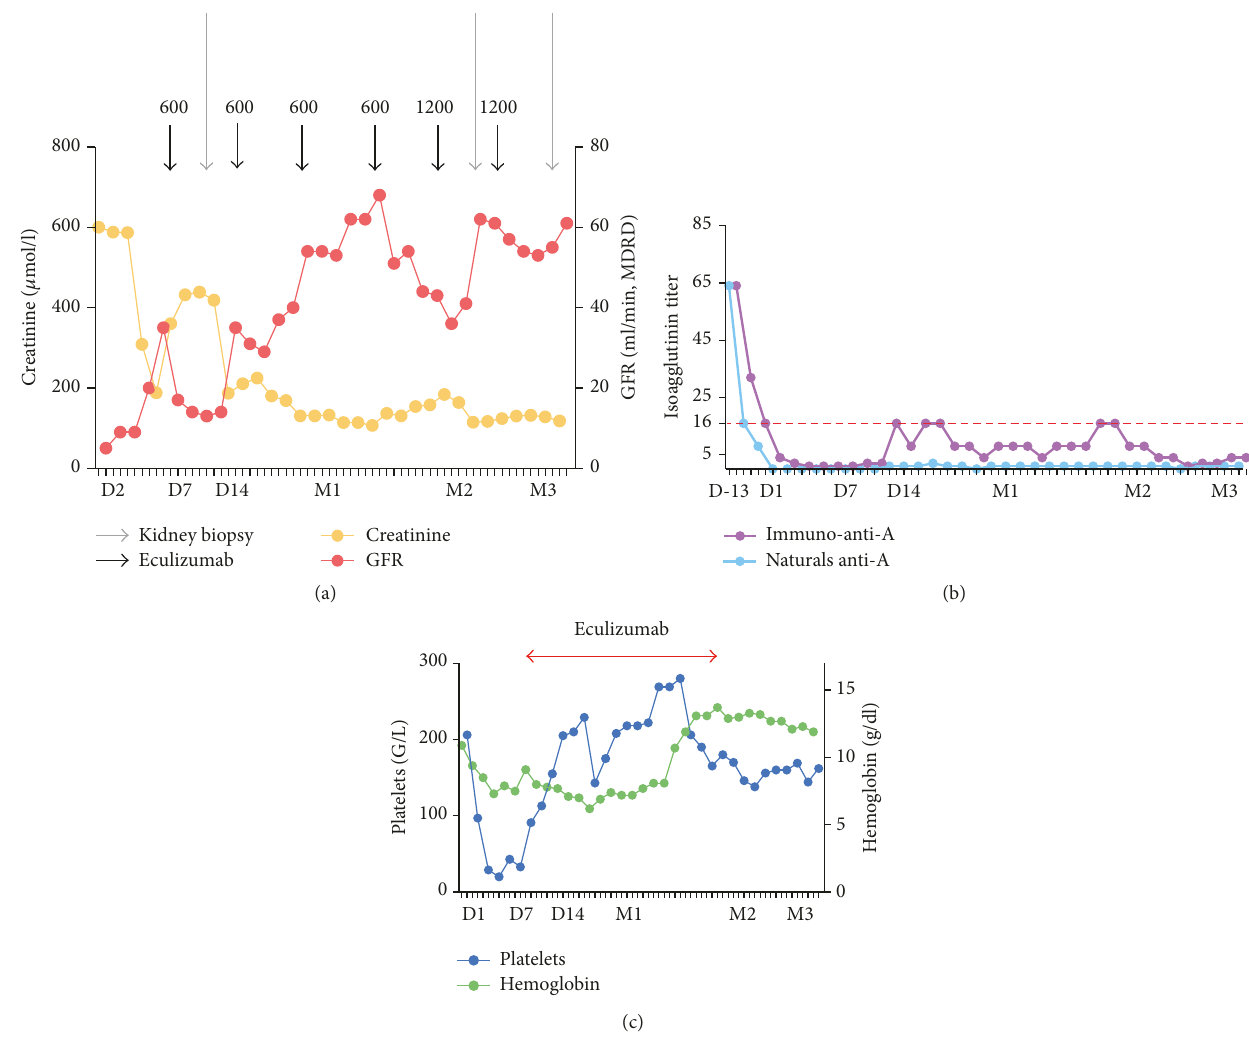
Figure 2: Kidney function (a), isoagglutinin titers (b), and hematological parameters (c) in patient 2. Evolution after